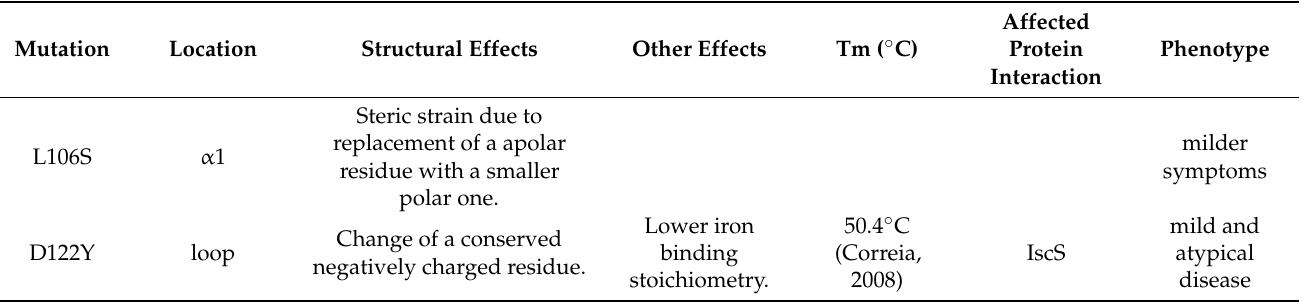
Table 2. Summary of frataxin point mutations in FRDA: the location and effect on the protein structure, temperatures of unfolding (as a reference, T m of the frataxin wild-type is 60 ◦ C, as reported by Adinolfi, 2004 [94]), protein interaction site and FRDA phenotype.